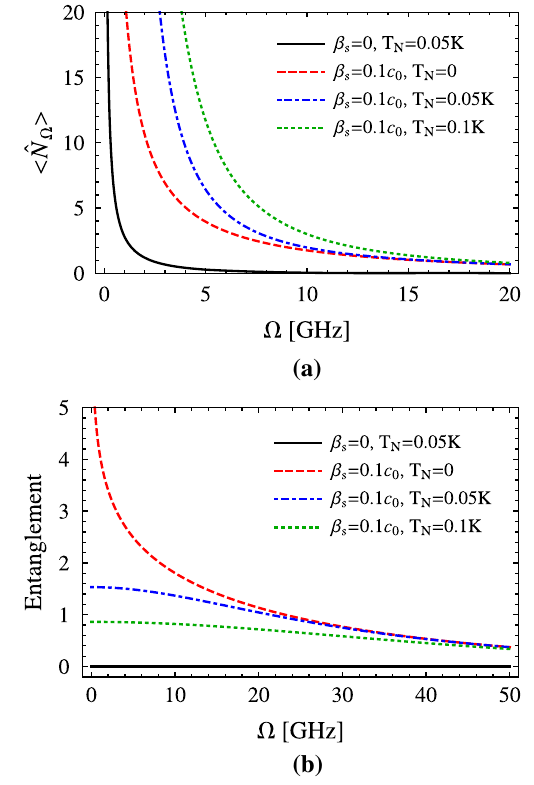
Fig. 3 a The radiation spectrum of Eq. (8) as a function of particle frequency seen from the comoving frame; b the entanglement of cre- ated particles in the presence of thermal noise as a function of particle frequency seen from the comoving